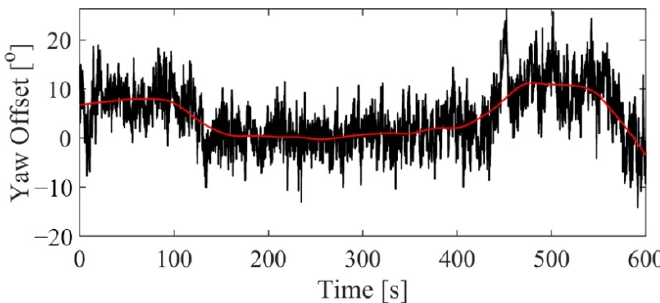
Figure 4. Yaw offset in time between the wind and the turbine; ( ⎯ ) SCADA measurement and ( ⎯ ) prescribed to the turbine on the numerical simulation.